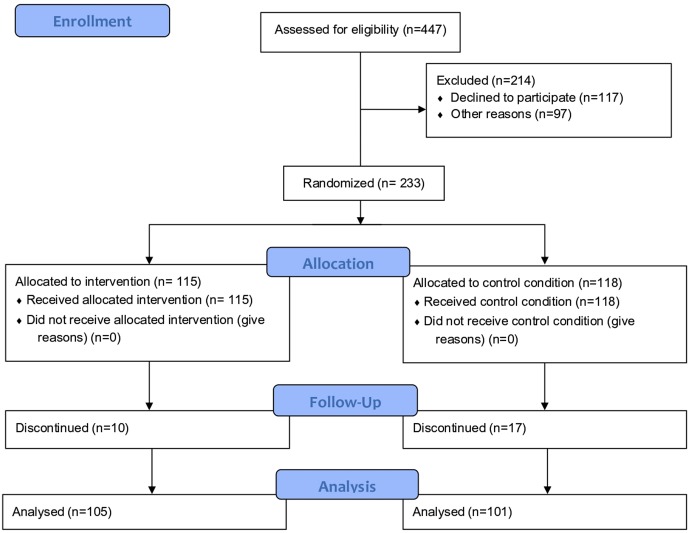
CONSORT flowchart of study participants.